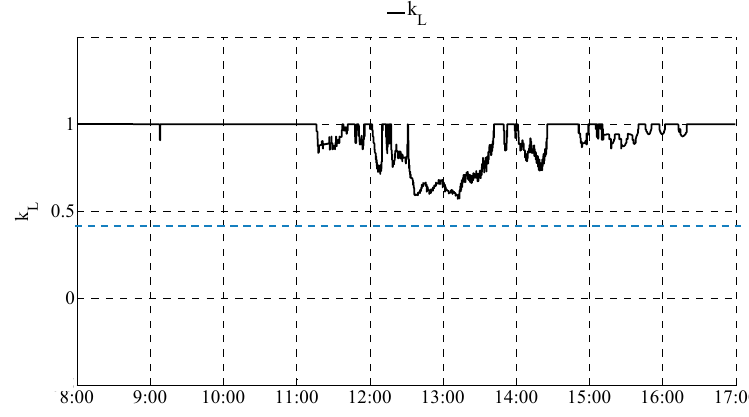
Figure 9. Load shed percentage evolution.